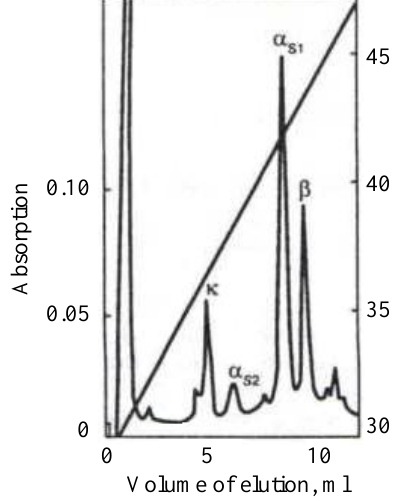
Fig. 3. Сhromatogram of milk